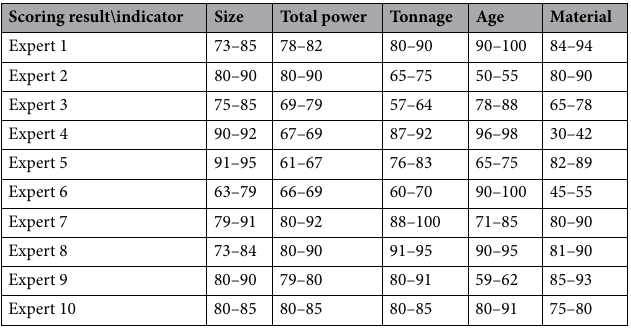
Table 10. Scoring result (specification).